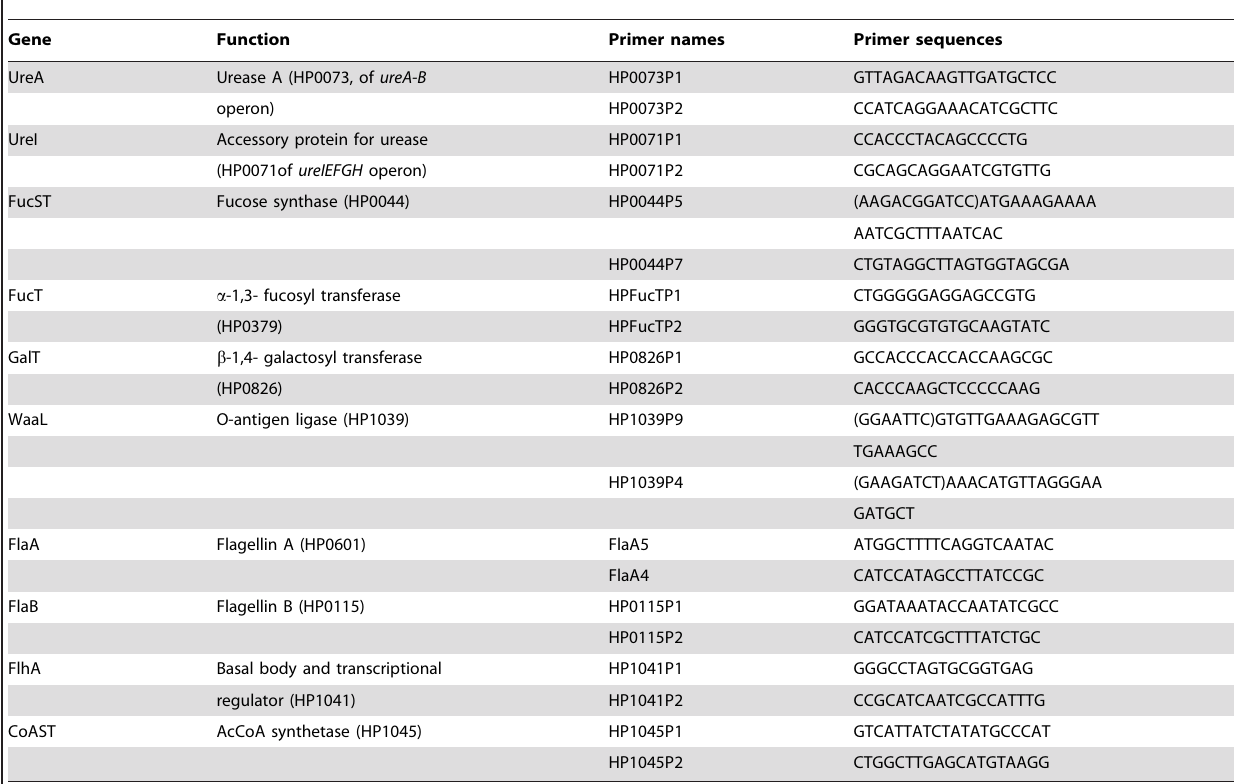
Table 1. List of genes whose expression was investigated by